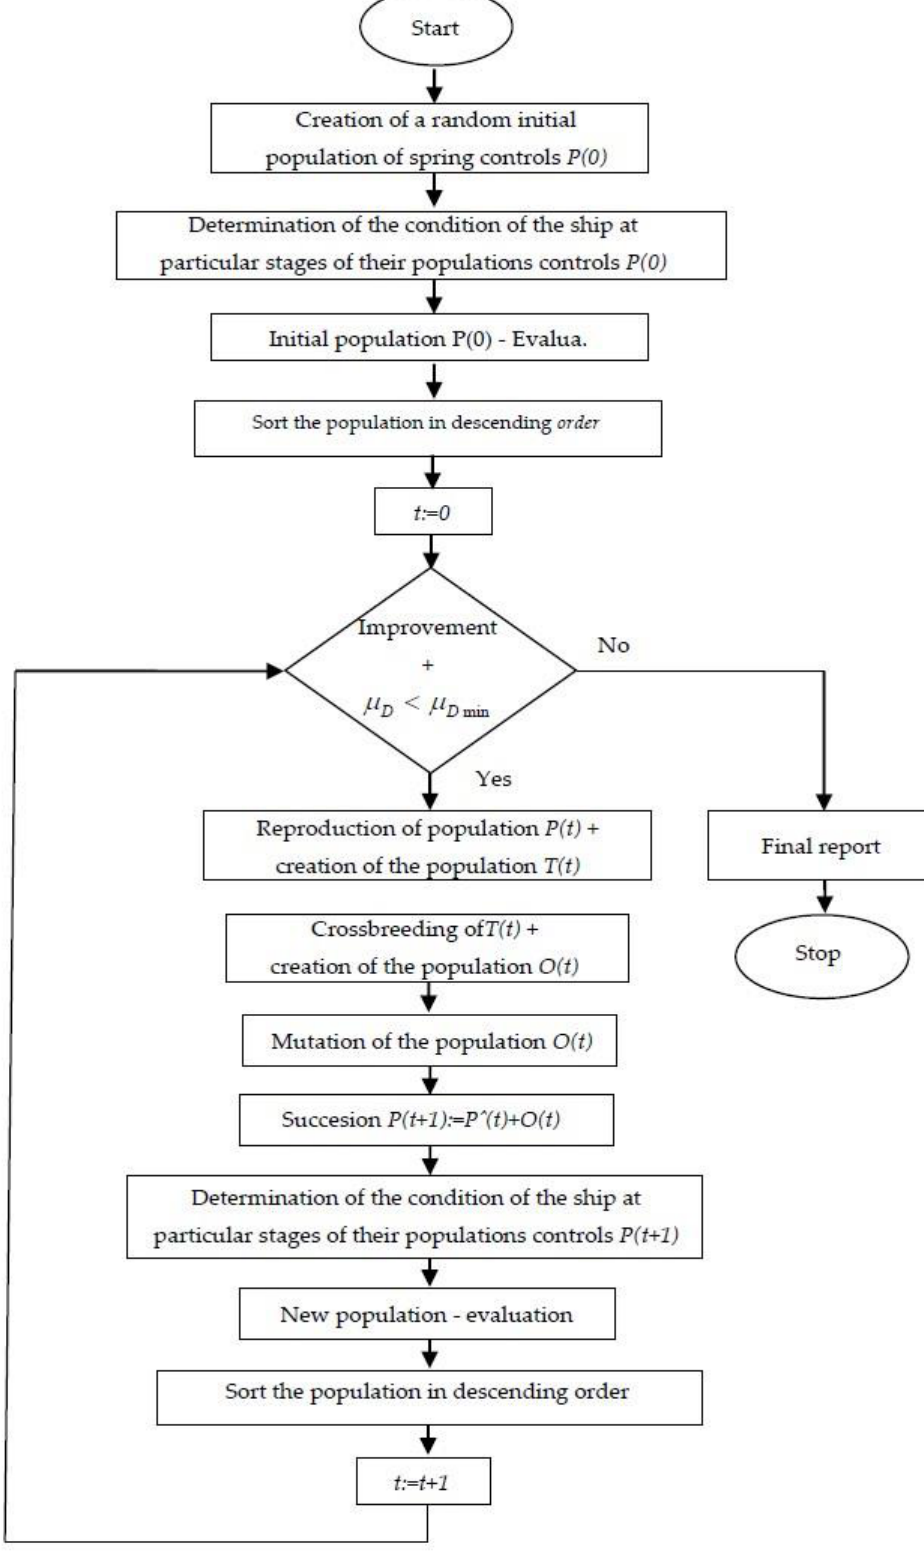
Figure 3. The f lowchart of the anticollision evolutionary algorithm (ACEA). Figure 3. The flowchart of the anticollision evolutionary algorithm